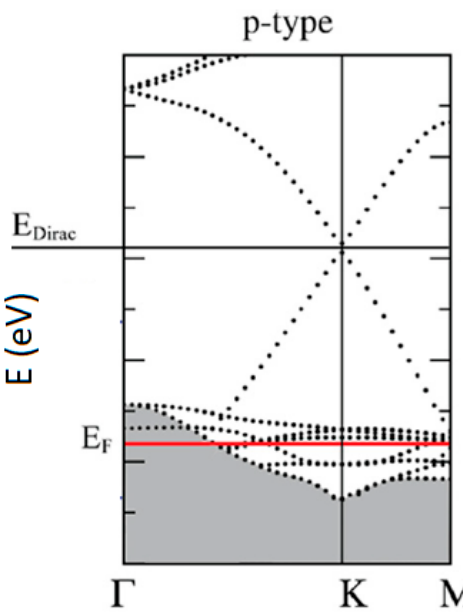
Figure 12. P-type doping of graphene upon the ambient exposure at 300 K. The p-type doping correspond to depletion of 4.5 × 10 14 electrons / cm − 2 . Adapted with permission from Reference [5]. Copyright (2012) AIP Publishing.